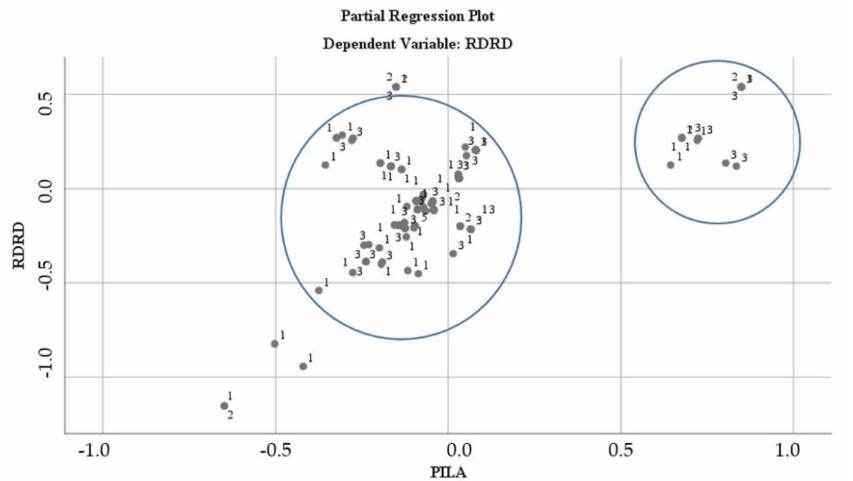
Figure 3. Regression analysis for